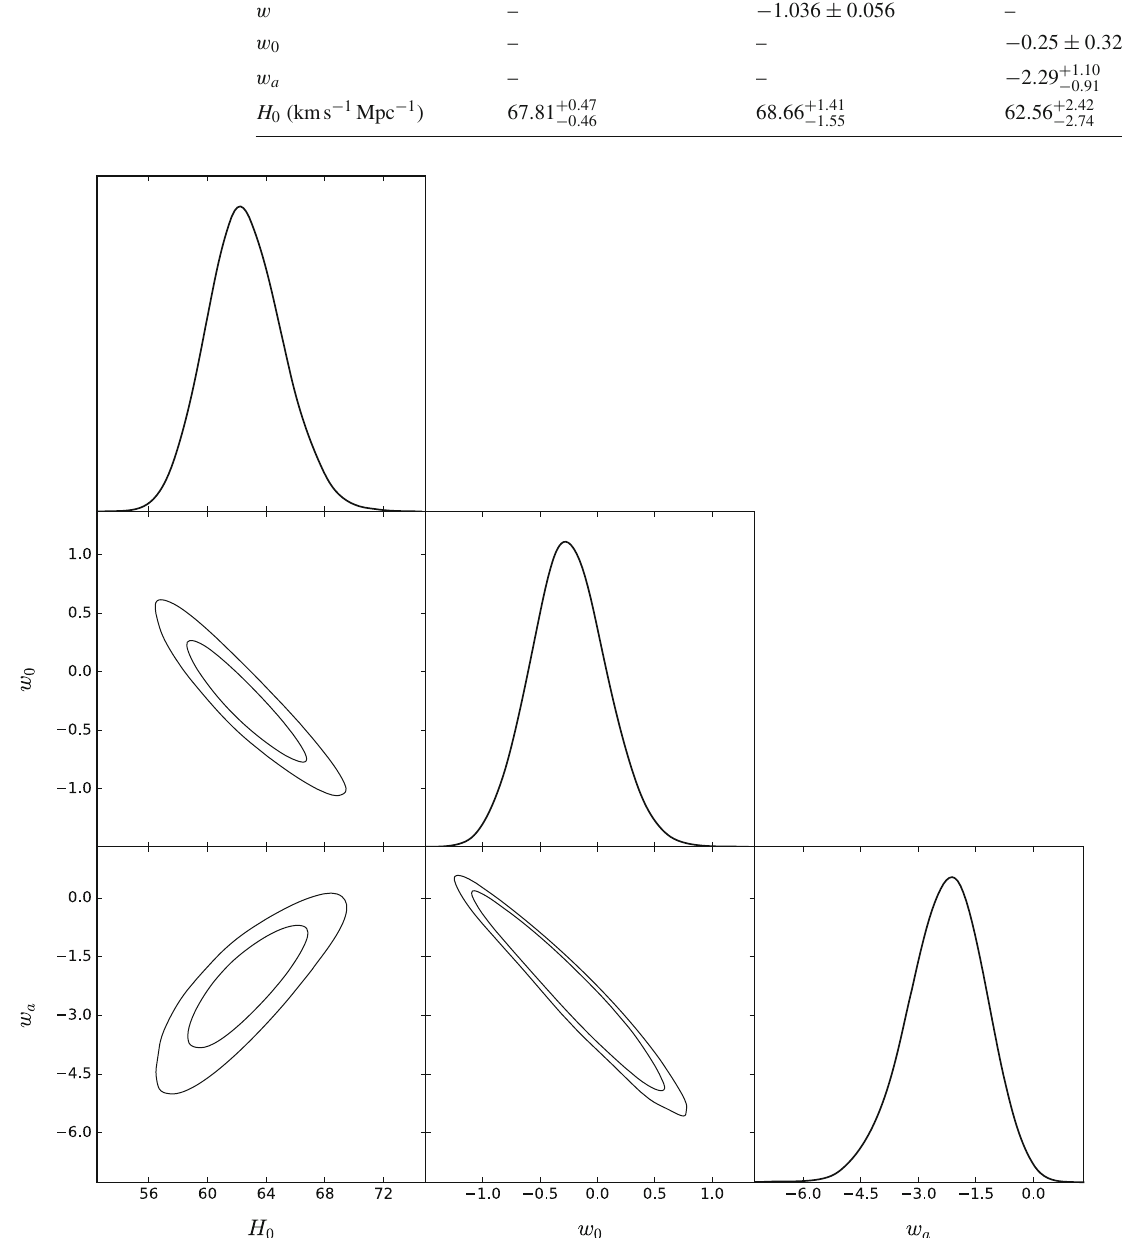
Fig. 1 The triangular plot of H 0 , w 0 and w a in the w 0 w a CDM model. The point ( w 0 = − 1, w a = 0) locates in the w 0 w a CDM 68% C.L.